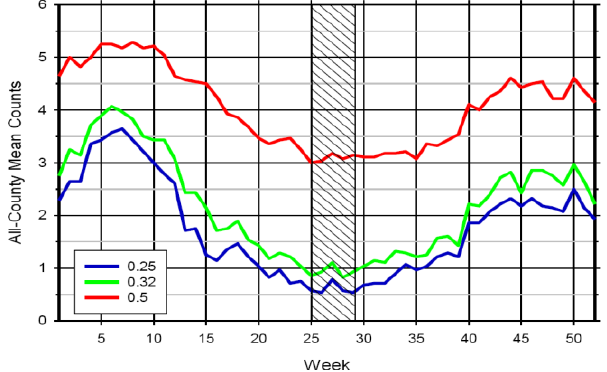
Figure 3. The mean weekly occurrence of ILI events in all counties based on the defined standard deviations (0.25 σ , 0.32 σ and 0.5 σ